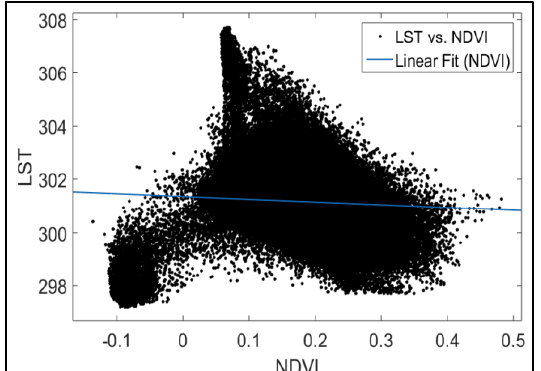
Figure 3.Scatter plot of LST with NDVI